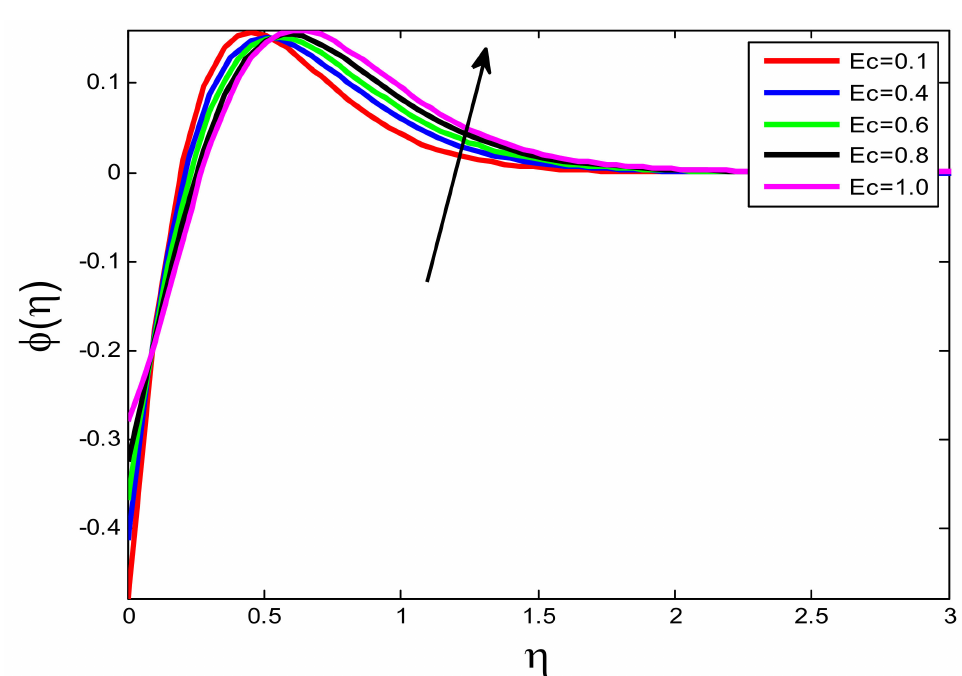
Figure 25. Influence of Ec on φ ( η )